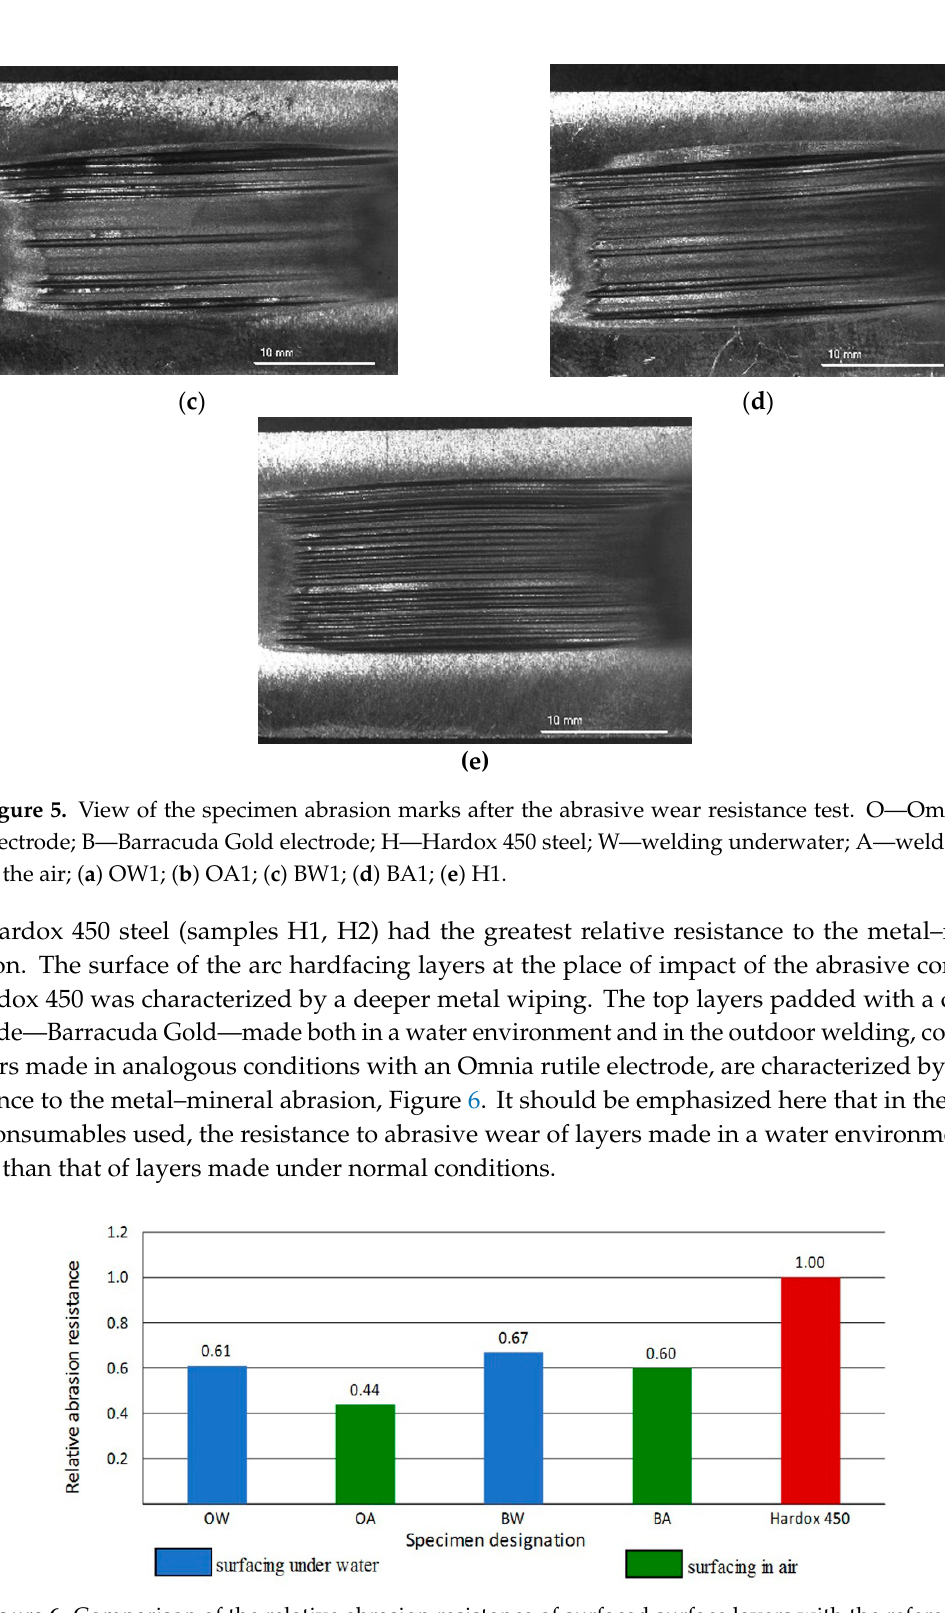
Figure 6. Comparison of the relative abrasion resistance of surfaced surface layers with the reference material—Hardox 450 steel.